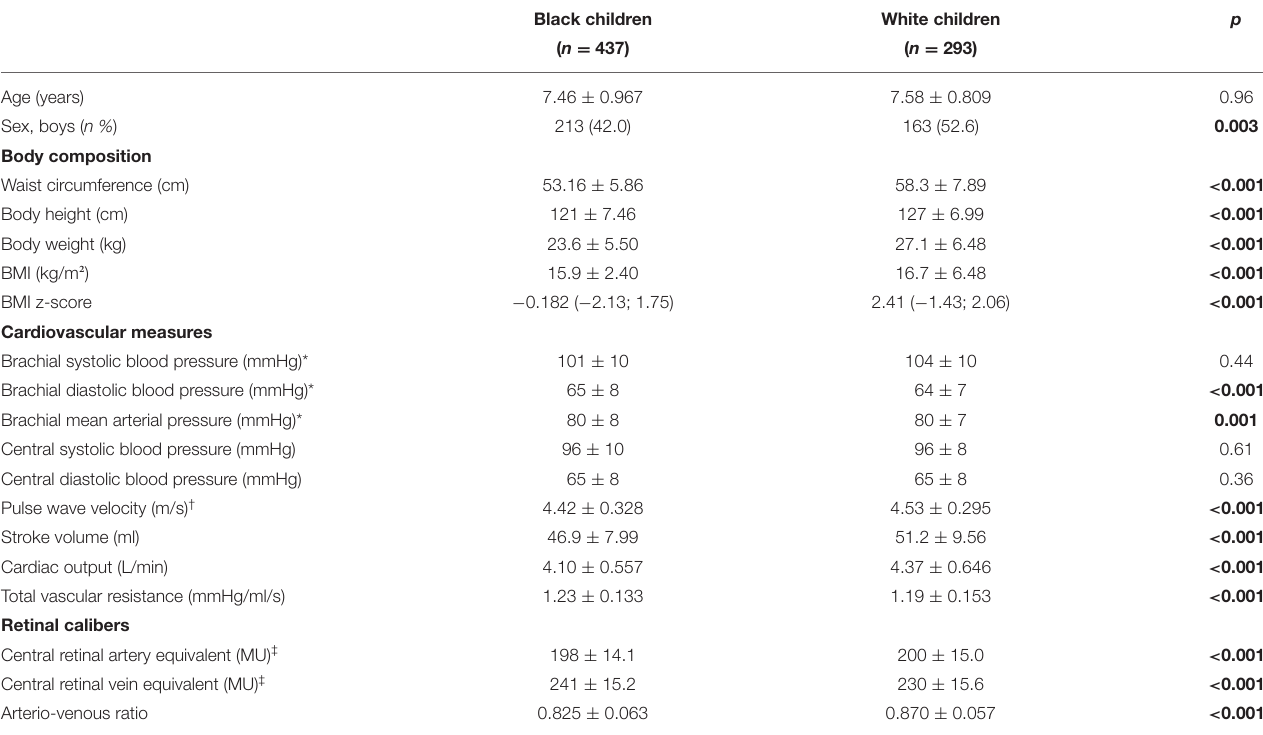
TABLE 1 | General characteristics of children stratified according to